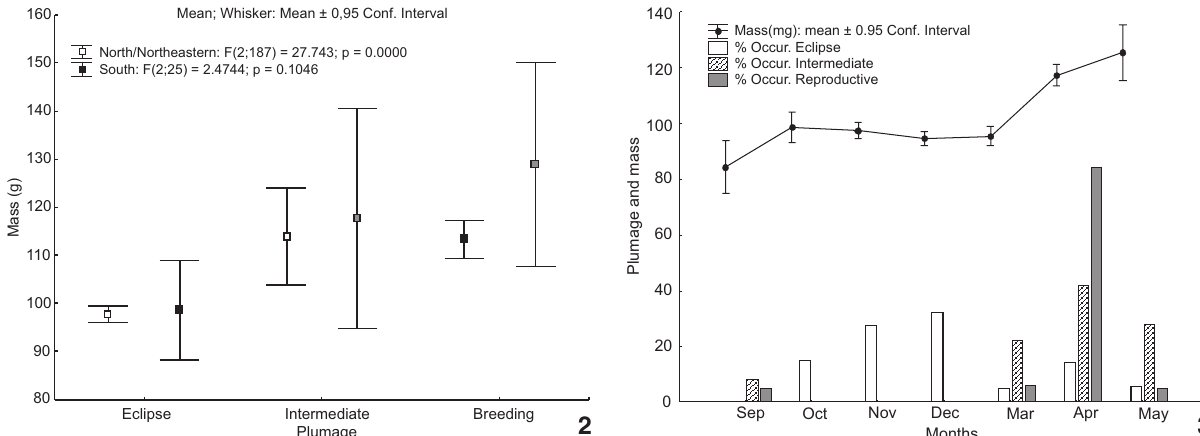
pended) their body feathers moult between April and May. In respectively.